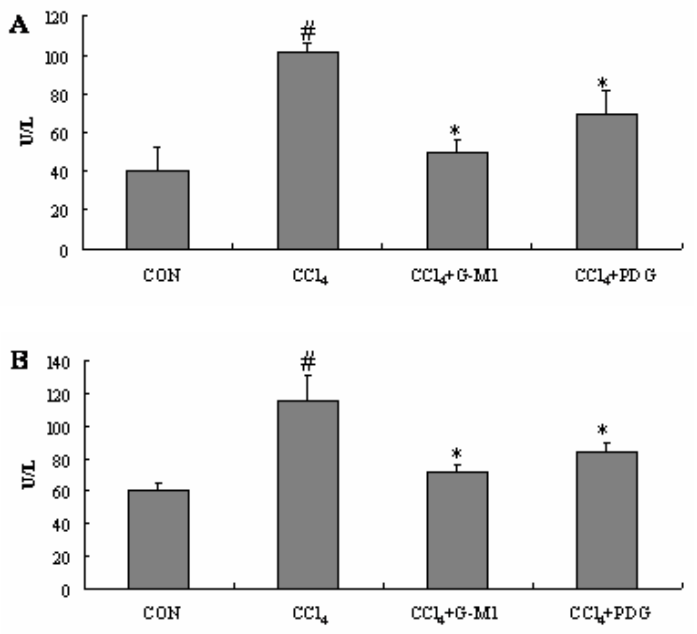
Figure 4. Effect of PDG and G-M1 on serum ALT and AST levels in CCl injury in mice. PDG and G-M1 were administrated for a period of 4 weeks at dose of 300 mg/kg and 30 mg/kg, respectively. Each value is mean ± S.D. for 12 mice in each group. * Significance P < 0.05, compared with CCl compared with normal control group.